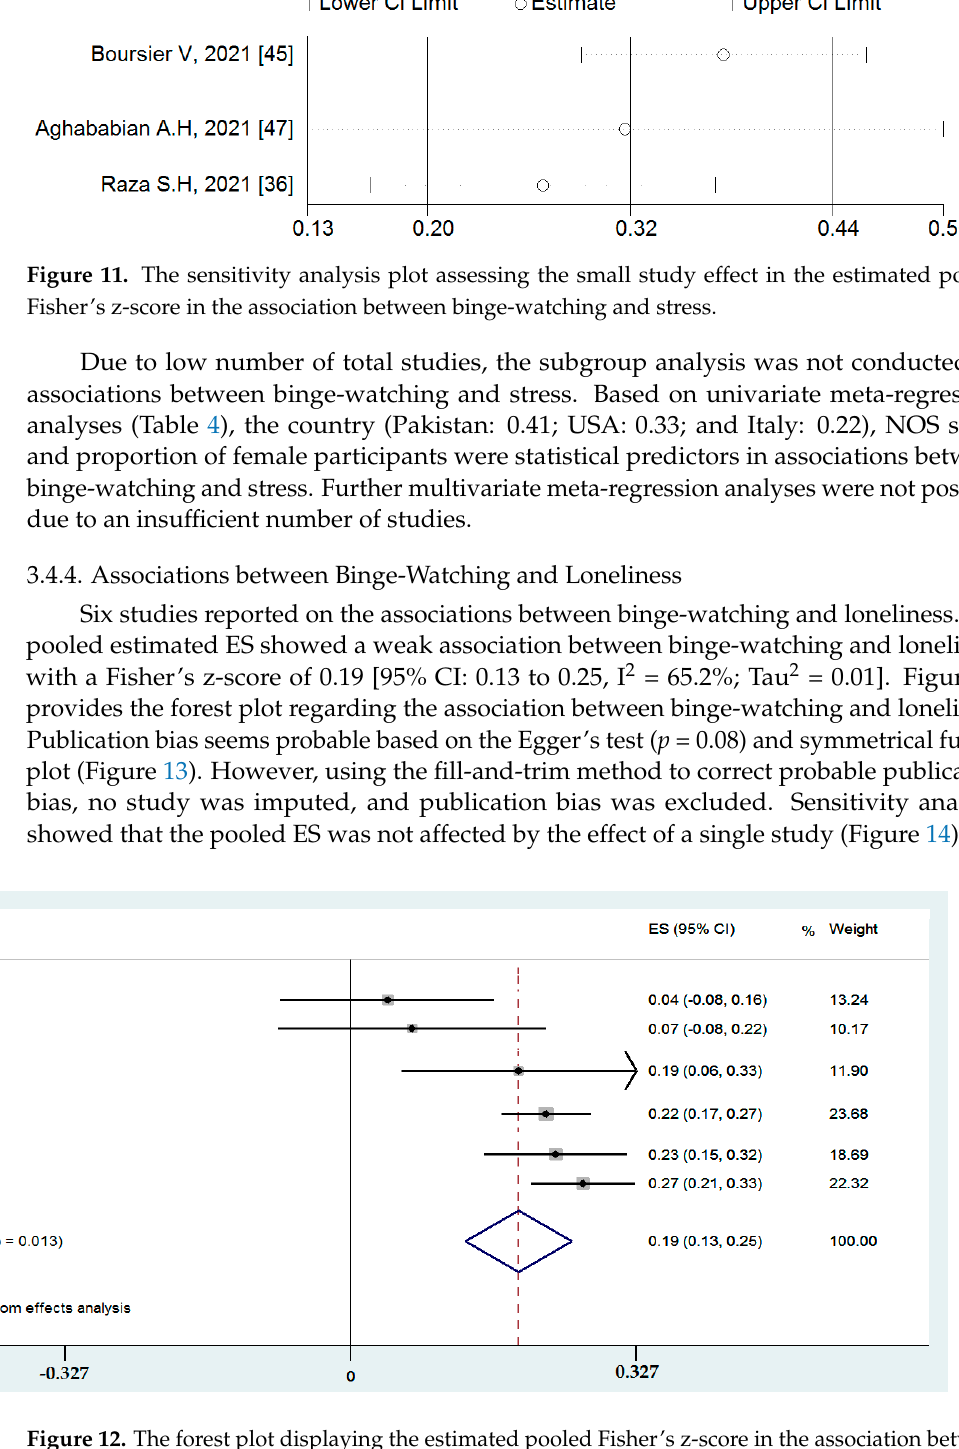
Figure 10. The funnel plot displaying the estimated pooled Fisher’s z-score in the association between binge-watching and stress.